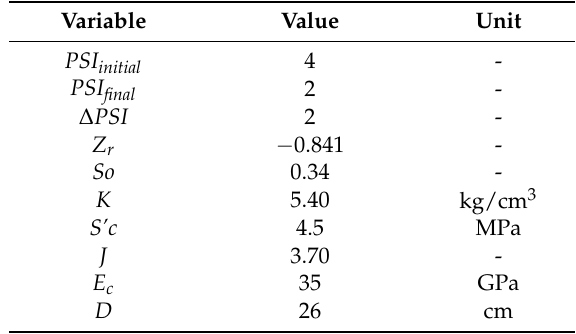
Table 5. Input data for pavement design.